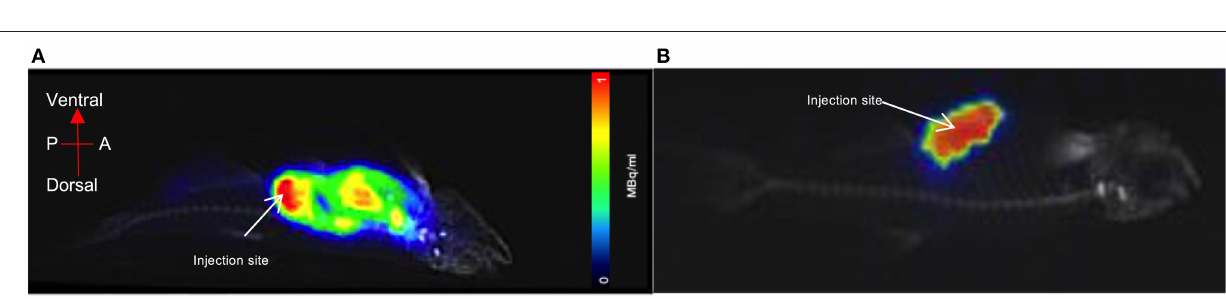
FIGURE 5 | PET acquisition of a euthanized zebrafish inside the imaging platform. (A) The mixture of CT contrast and [ 18 F]FDG (0.5MBq) was injected into the pectoral cavity immediately following confirmed death and allowed to circulate for 30min prior to imaging. Distribution and uptake of the activity can be seen away from the injection site. The tracer distribution away from the injection site (red) areas will represent metabolically active organs such as the liver, gut or heart. (B) For visual comparison of [ 18 F]FDG uptake and distribution, radiotracer has remained at the injection site (pectoral